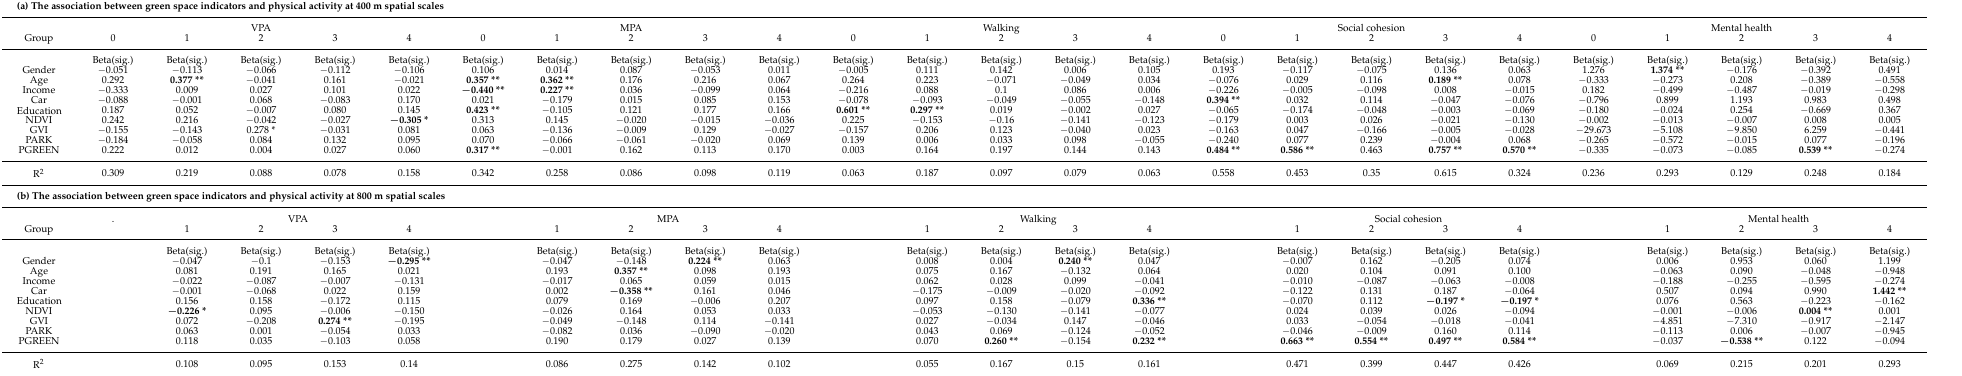
Table 1. The association between green space indicators and physical